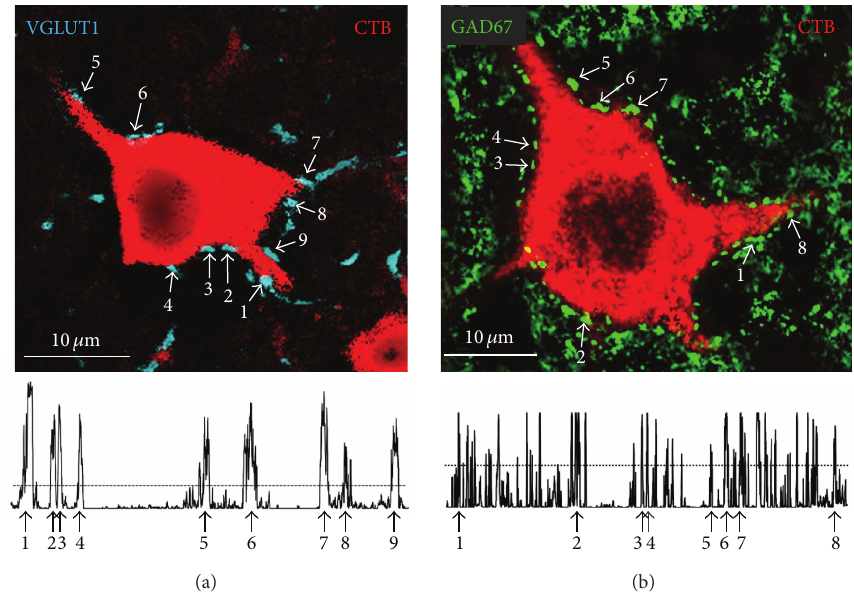
Figure 1: Images containing motoneurons retrogradely labeled with the beta subunit of cholera toxin (CTB) (red) are shown from spinal cord sections from intact wild-type mice to illustrate the ways that measurements of synaptic coverage were made. In panel (a), immunoreactivity to vesicular glutamate transporter 1 (VGLUT1) is marked by cyan. In panel (b), immunoreactivity to glutamic acid decarboxylase (GAD67) is shown in green. Each image is from a single optical section of the cell made through the nucleus. In all of the cells studied, the perimeter of the cell was outlined to create a region of interest (ROI) and a profile plot (shown below each image) of the fluorescence intensity along the ROI, in the appropriate channel of the RGB image, was obtained using Image J. The locations of some, but not all, prominent VGLUT1 or GAD67 immunoreactive terminals in contact with the motoneuron soma are indicated by numbers in the micrographs and the labeled peaks on the associated profile plot. The dotted line across each profile plot represents the threshold used to define the amount of synaptic coverage in this cell. Portions of the profile plot above this line are considered regions of the cell surface that are contacted by structures immunoreactive for these synapse-associated